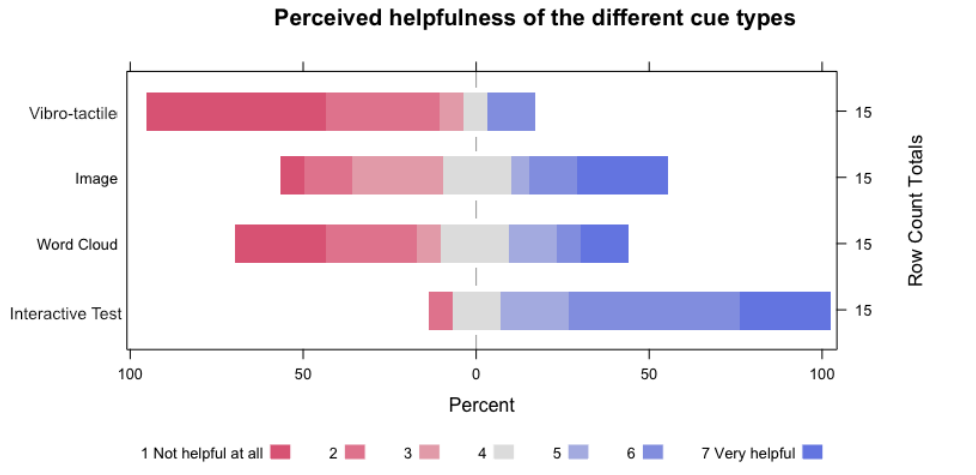
Figure 10. Perceived helpfulness of the different cue types on a scale from 1 = not at all to 7 = very helpful for the revised cue designs